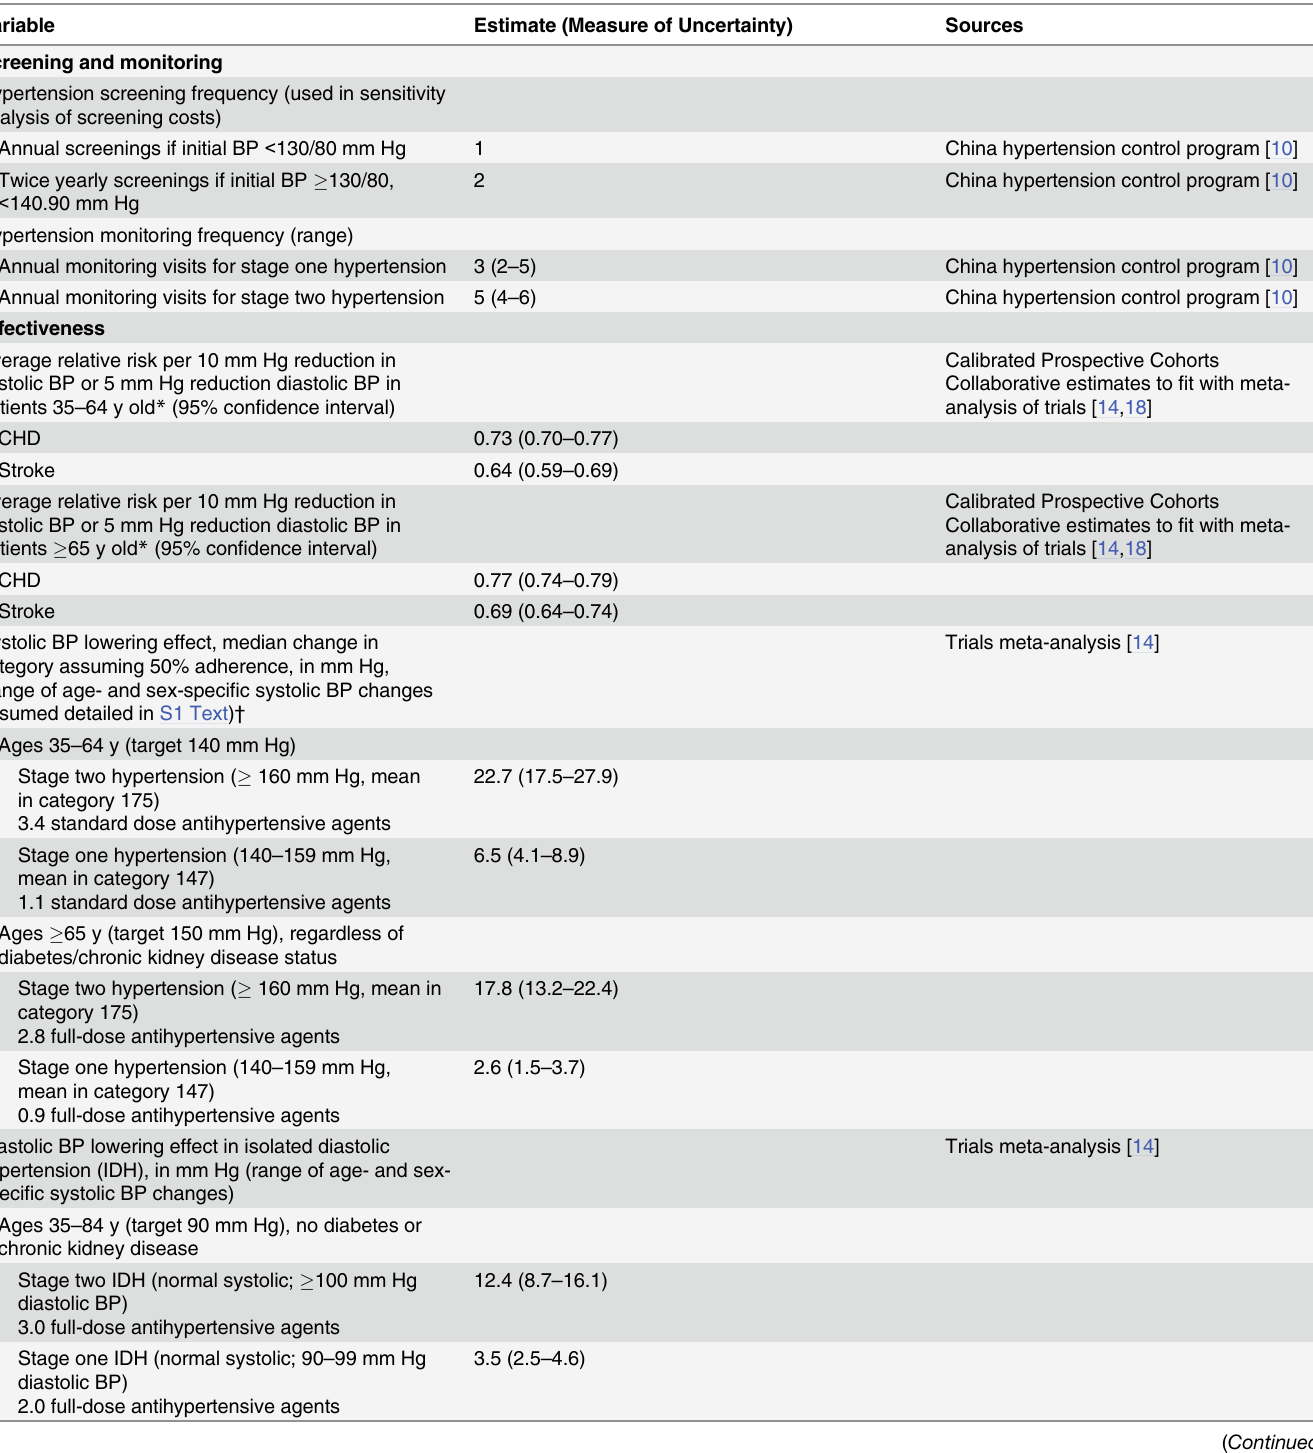
Table 1. Main assumptions for the cost-effectiveness analysis of China hypertension control